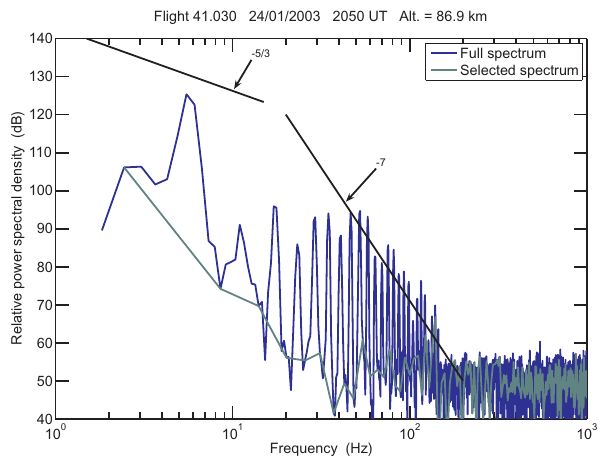
Fig. 7. An example from Flight 41.030 of the use of frequency domain filtering to reduce the effects of payload roll modulation on the Heisenberg spectra fit. Notice that the filtered spectrum is quite different from the unfiltered spectrum at this altitude of 84.6km.